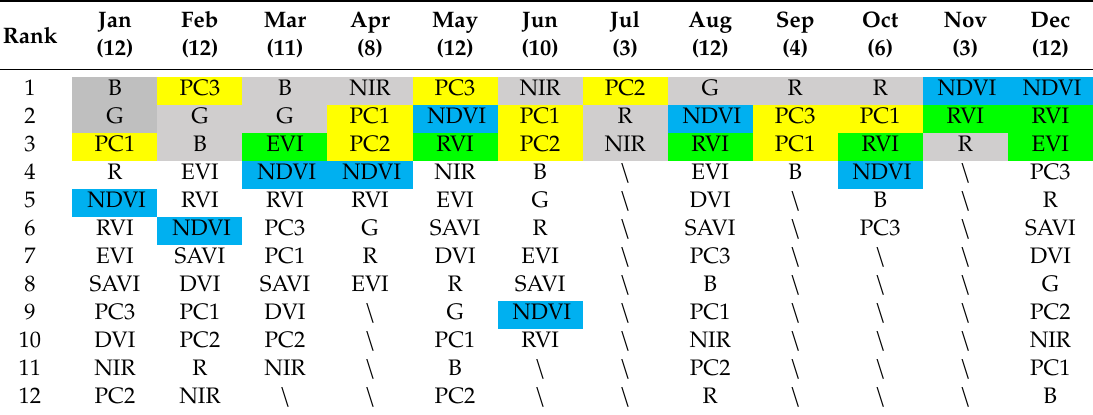
Table 4. Optimal variables sizes and subsets for 12 single-scene analyses (SSAs) selected by using the RF-RFE algorithm. The top three variables and the NDVI variable are highlighted in di ff erent colors. The VIs are highlighted in green, the PCs are highlighted in yellow, and the original bands are highlighted in gray. Values in parentheses are the optimal variable sizes for each SSA. R, Red; G, Green; B, Blue; N, Near-Infrared